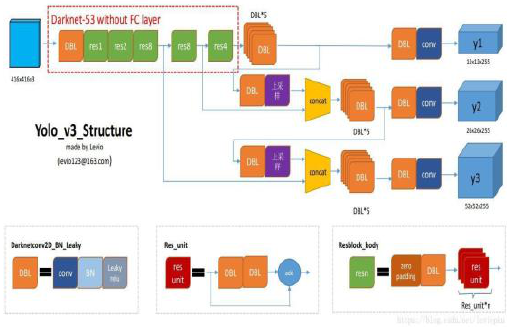
Figure 2 YOLOv3 target detection framework